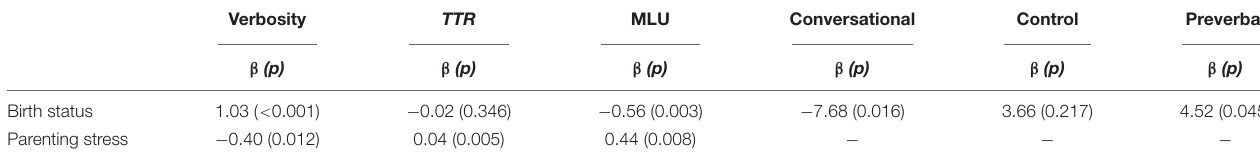
TABLE 7 | Multivariate analysis on IDS linguistic and pragmatic characteristics: Standardized estimated parameters of models 2 and 1, respectively. Verbosity MLU